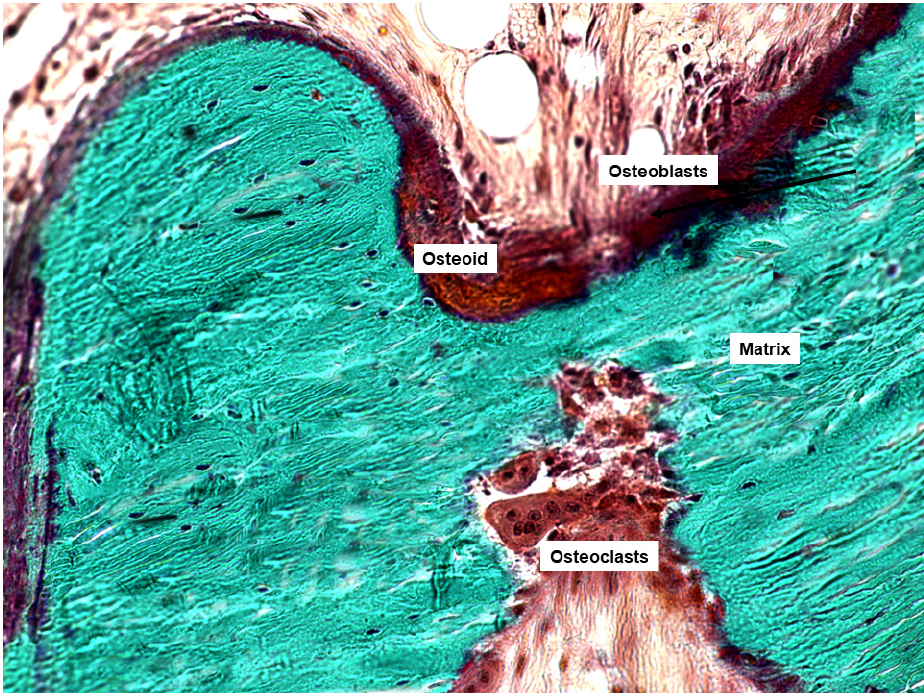
Figure 4. Goldner trichrome-stained bone section in which we can see osteoblasts, osteoclasts and osteoid, the main product of osteoblasts.